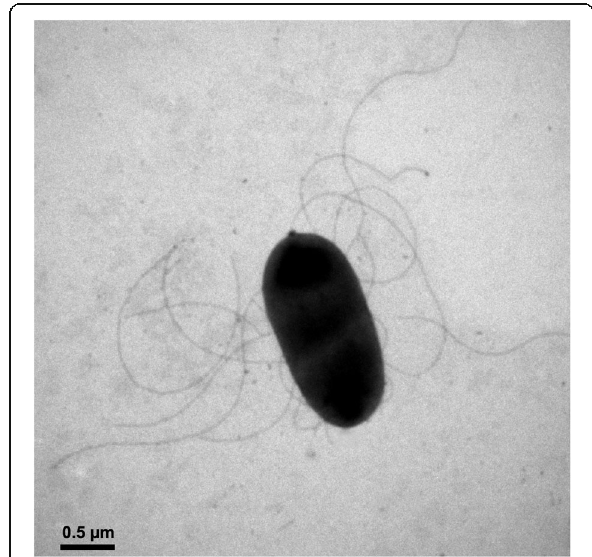
Fig. 1 Cell morphology of the Kosakonia oryzae type strain Ola 51 T . The bacterium was stained by uranyl acetate and observed by a transmission electron microscope